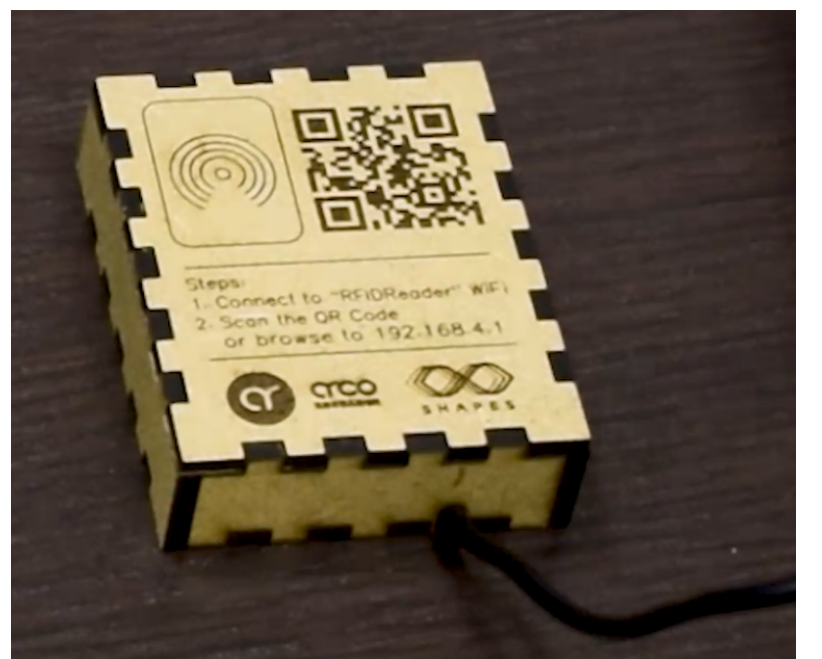
Figure 7. Wristband RFID writer